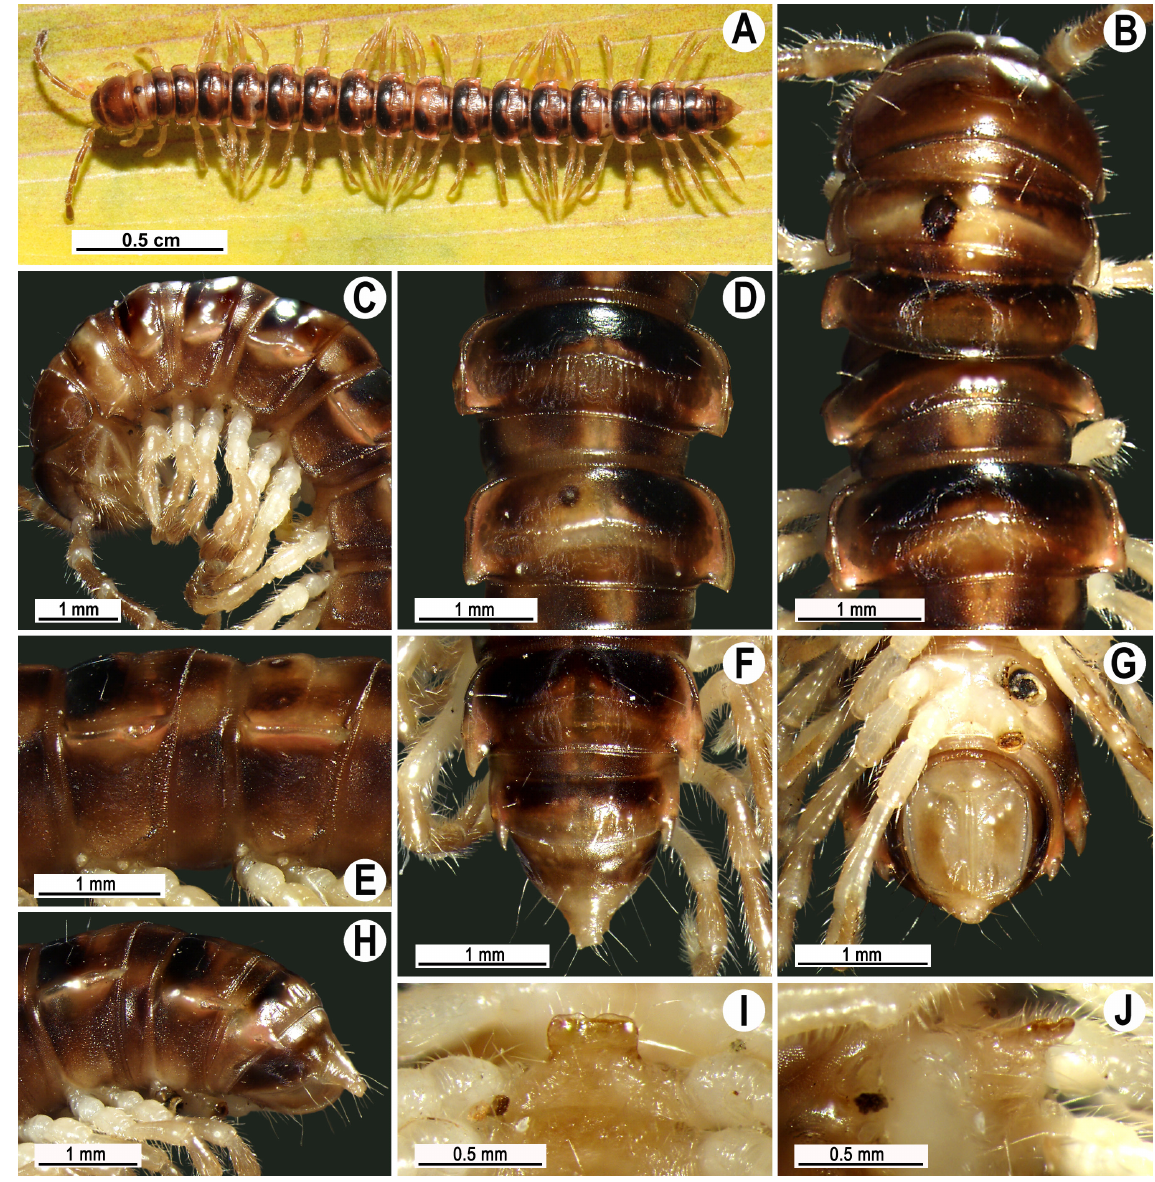
Fig. 16. Tylopus dorsalis sp. nov., holotype, ♂. A . habitus, live coloration. B–C . anterior part of body, dorsal and lateral views, respectively. D–E . Segments 10 and 11, dorsal and lateral views, respectively. F–H . Posterior part of body, dorsal, ventral and lateral views, respectively. I–J . Sternal cones between coxae 4, caudal and sublateral